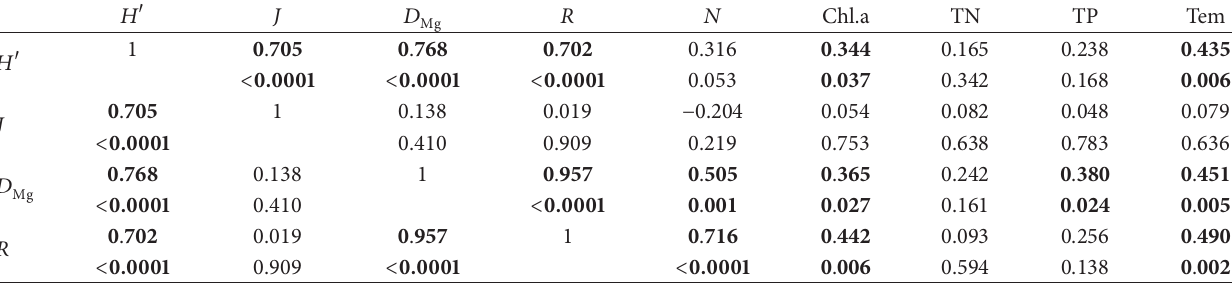
Table 4: Correlations between the diversity indices, including the Shannon-Wiener index ( 𝐻 󸀠 ), species richness ( 𝑅 ), evenness index ( 𝐽 ), ), total rotifer density ( 𝑁 ), and environmental factors. Margalef’s index ( 𝐷 Mg 𝐻 󸀠 𝐽 𝐷 𝑅 𝑁 Mg